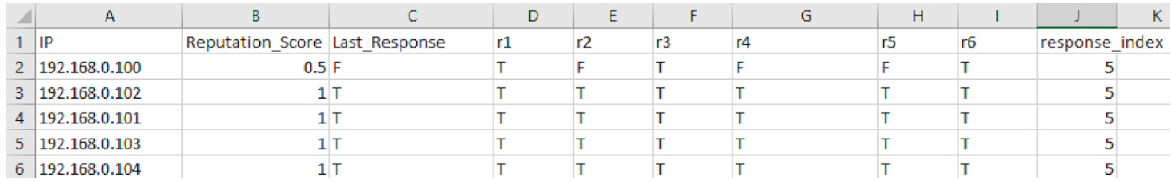
Figure 17. Reputation.xlsx file information format and score keeping of the nodes.